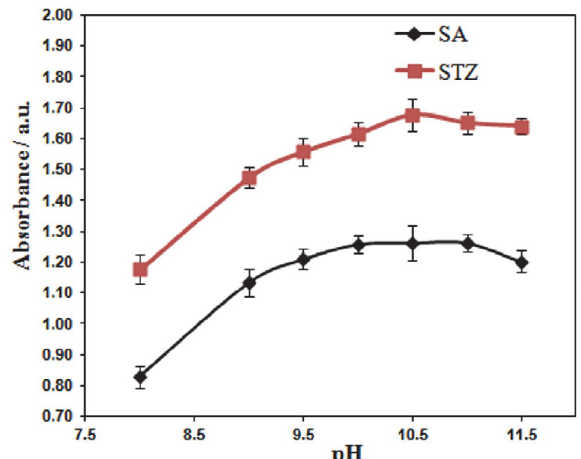
Fig. 5. Effect of medium acidity on SA and STZ diazonium salt azo- coupling with AM. 1. C SA = 2.0 . 10 –4 M, C HCl = 0.6 M; 2. C STZ = 2.0 = 3.0 . 10 –3 M, C AM = 5.0 . 10 –5 M, . 10 –4 M, C HCl = 0.7 M; C NaNO 2 C